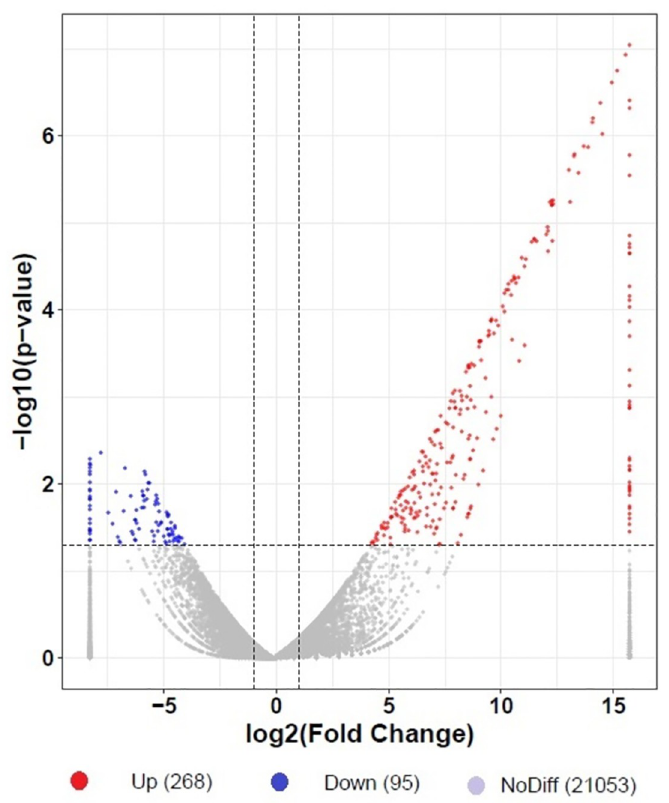
Fig 4. During the B . aryabhattai -Arabidopsis interaction, a volcano plot of differential gene expression was established. The log2-transformed fold changes are on the X-axis, while the -log10-transformed p values are on the Y- axis. The horizontal dashed lines represent the P value thresholds, while the vertical dashed lines show the difference thresholds (0.05). The scale was set based on the log2-transformed lowest and maximum values (between -7.60 and